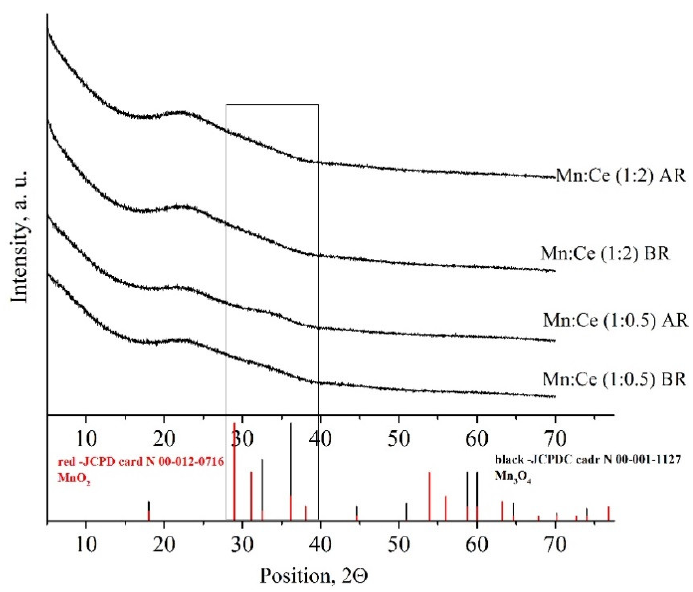
Figure 6. XRD patterns of MeCe (1:2) and MnCe (1:0.5) materials before and after reaction, and XRD peaks of Mn 3 O 4 (JCPDS card N 00-001-1127) and MnO 2 (card N 00-012-0716).